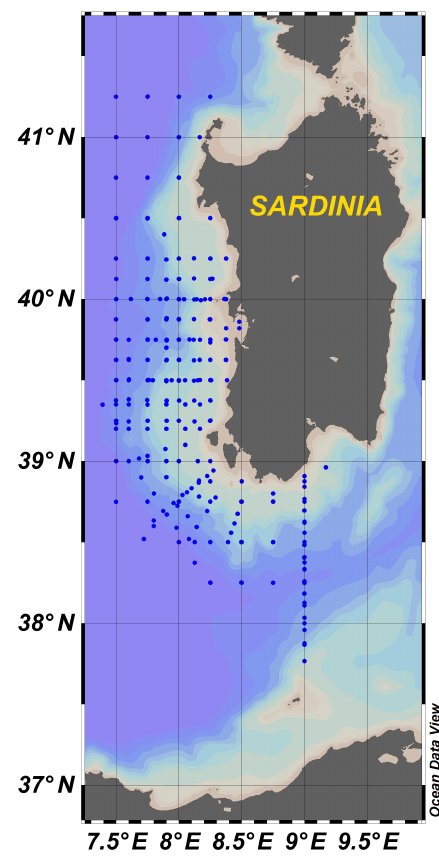
Figure 1. All the CTD casts during the seven cruises in the Sea of Sardinia (western